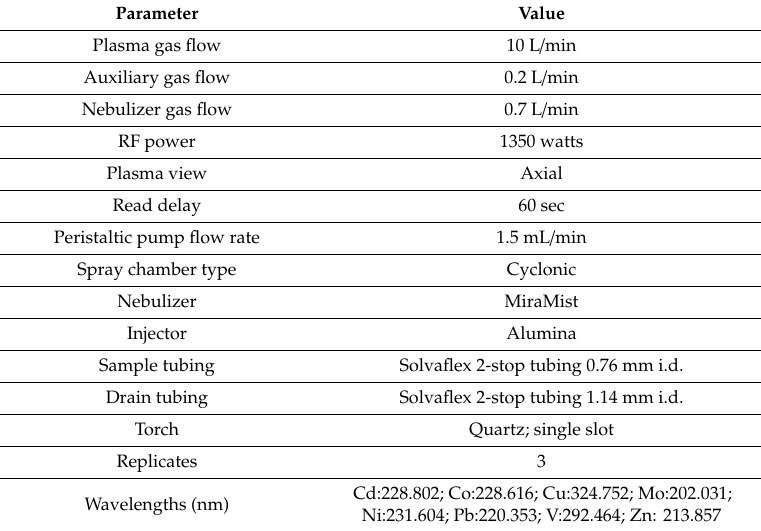
Table 1. ICP-OES operating conditions.